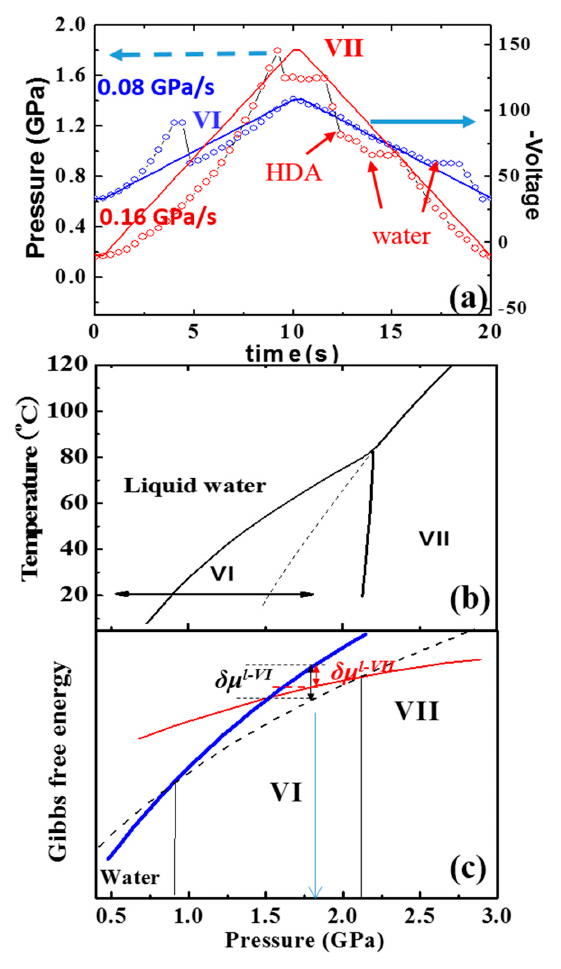
Figure 4. Pressure-time curves of H 2 O by dynamic diamond anvil cell (dDAC) ( a ) [9]. Phase diagram of H 2 O ( b ) and corresponding driving Gibbs free energy ( c ).